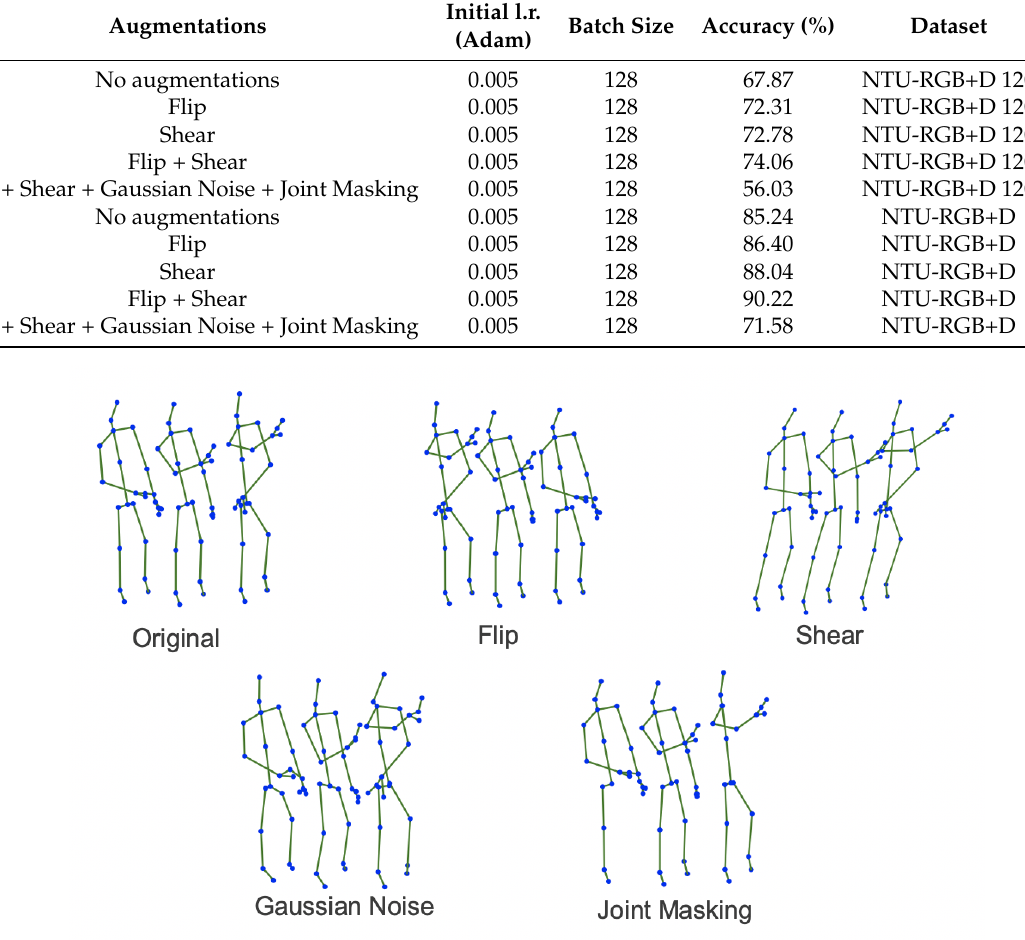
Figure 11. Examples of data augmentation applied on